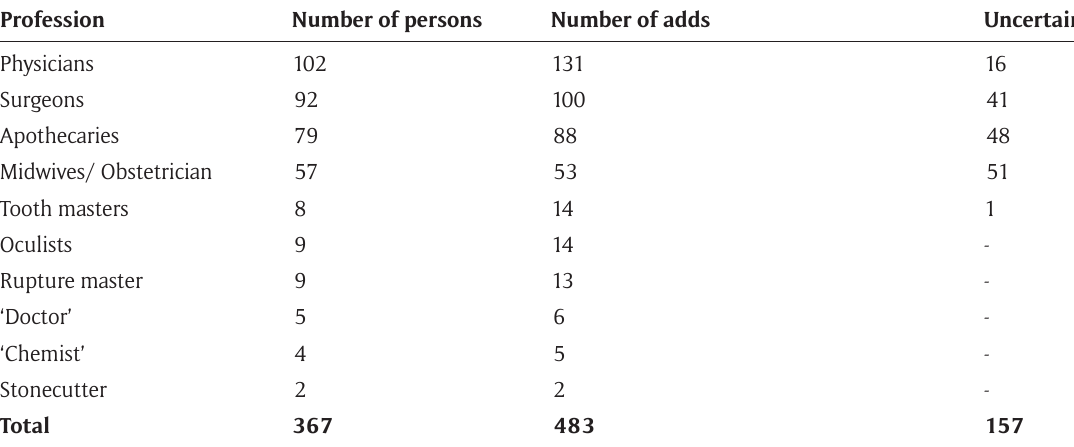
Table 1: Practitioners in OHC a . Profession